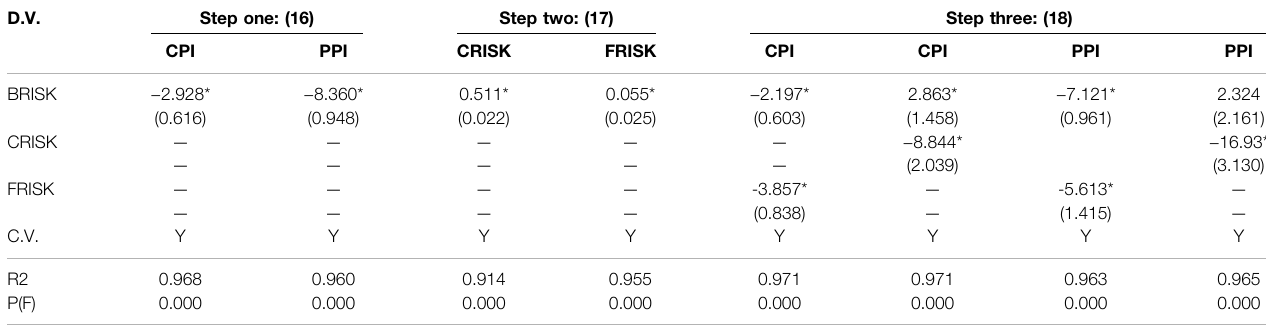
TABLE 6 | Test on the mediating effect of commodity market risk and fi nancial market risk when dual attribute of oil dominates.